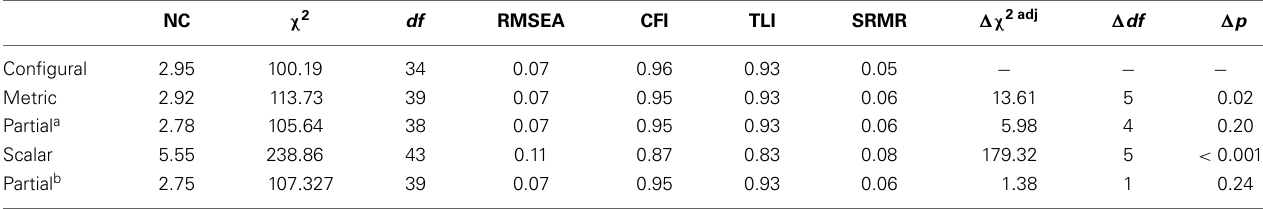
Table 3 | The measurement invariance analyses using ML.